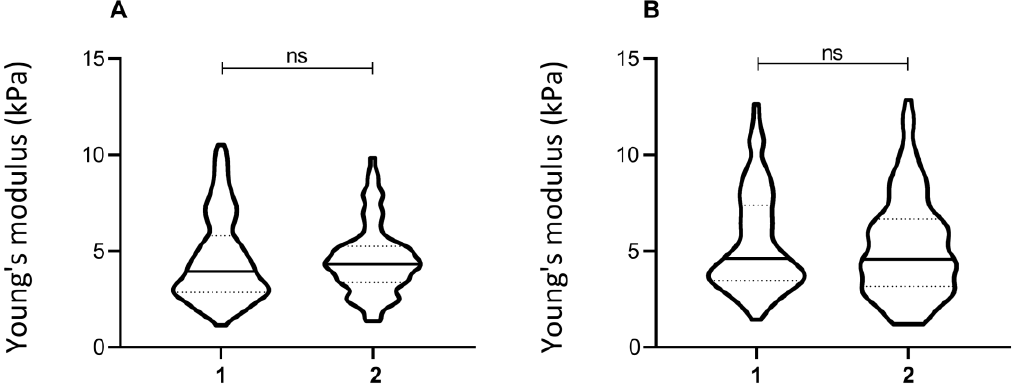
Figure 3. Young’s modulus of technical replicates. Elasticity values were acquired from technical replicates of two different fibroblast lines (line 1, in ( A ), and line 5, in ( B )) when the acquisition was repeated from different plates (1,2). The violin plot represents the distribution of single-cell Young’s modulus. The non-parametric Kolmogorov–Smirnov test was used to assess the statistical significance.